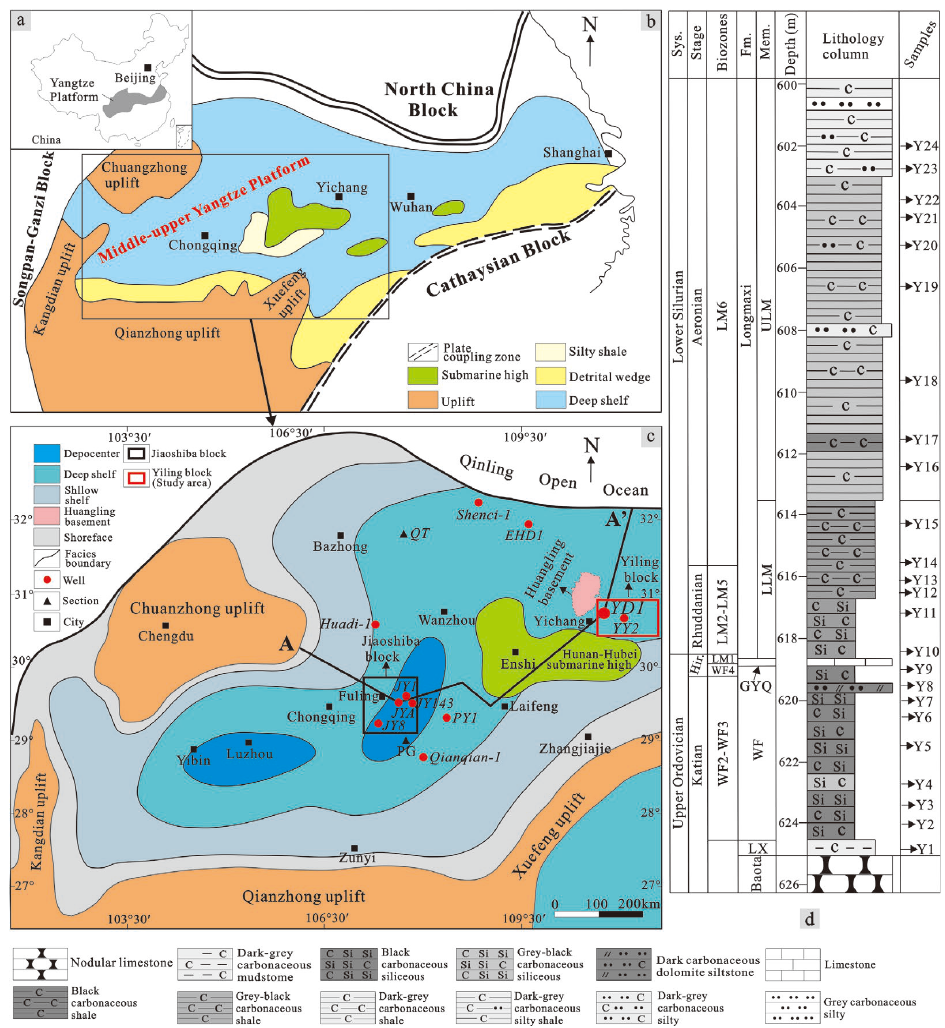
Figure 1. ( a ) Location of the Yangtze Platform in South China. ( b ) Palaeogeography of the Yangtze Platform in South China in the early Silurian (simplified from Zhang et al., 2019a [15]). ( c ) Palaeogeography of the middle - upper Yangtze Platform in the early Silurian showing the study area of the Yiling block in the southeastern Huangling basement (modified from Huang et al., 2020 [16]). ( d ) Lithostratigraphic column of well YD1 in the Yiling block showing black siliceous rock in the WF, black siliceous rock and argillaceous shales in the LLM are organic - rich shales. Note: LX, WF, GYQ, LLM, and ULM are the abbreviations for the Linxiang, Wufeng, Guanyinqiao, and lower and upper Longmaxi formations, respectively.